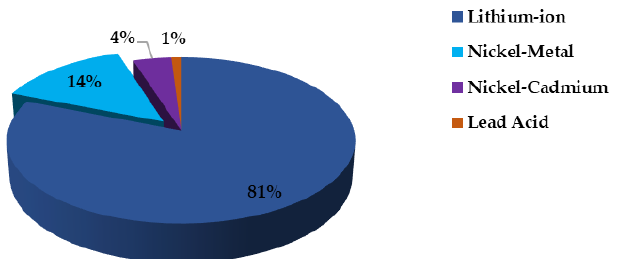
Figure 14. The collected %age of weight of different battery types recycled in 2013.